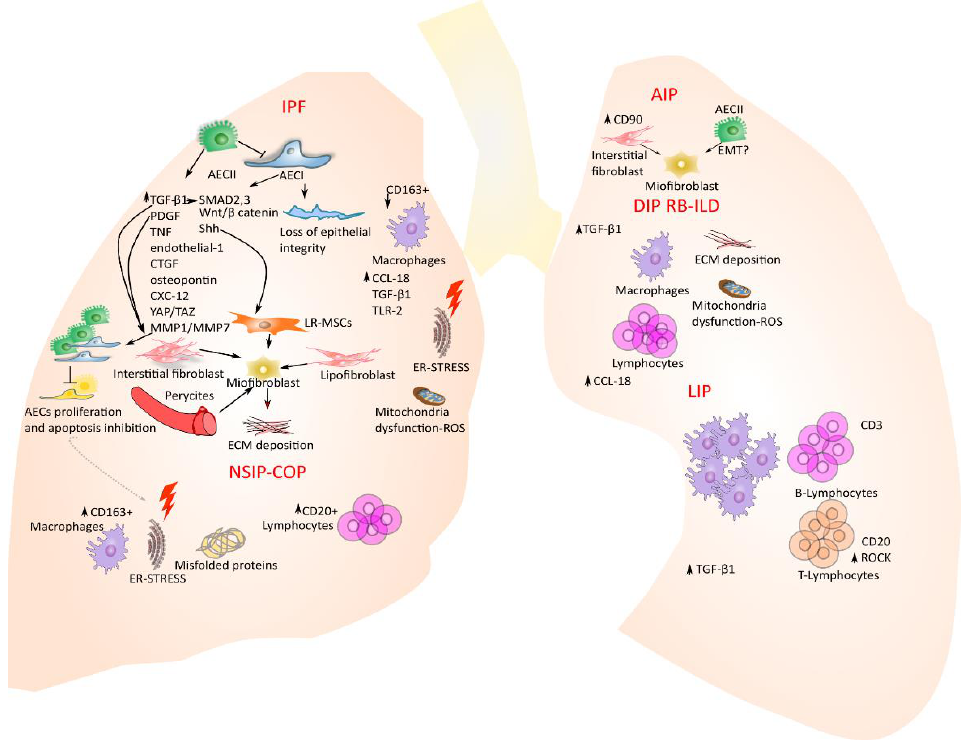
Figure 2. Molecular key players and signaling pathway characterizing the lung niche of IIP patients. Arrows indicate the molecular activation signaling leading to myofibroblasts activation and/or fibrotic disease progression process.